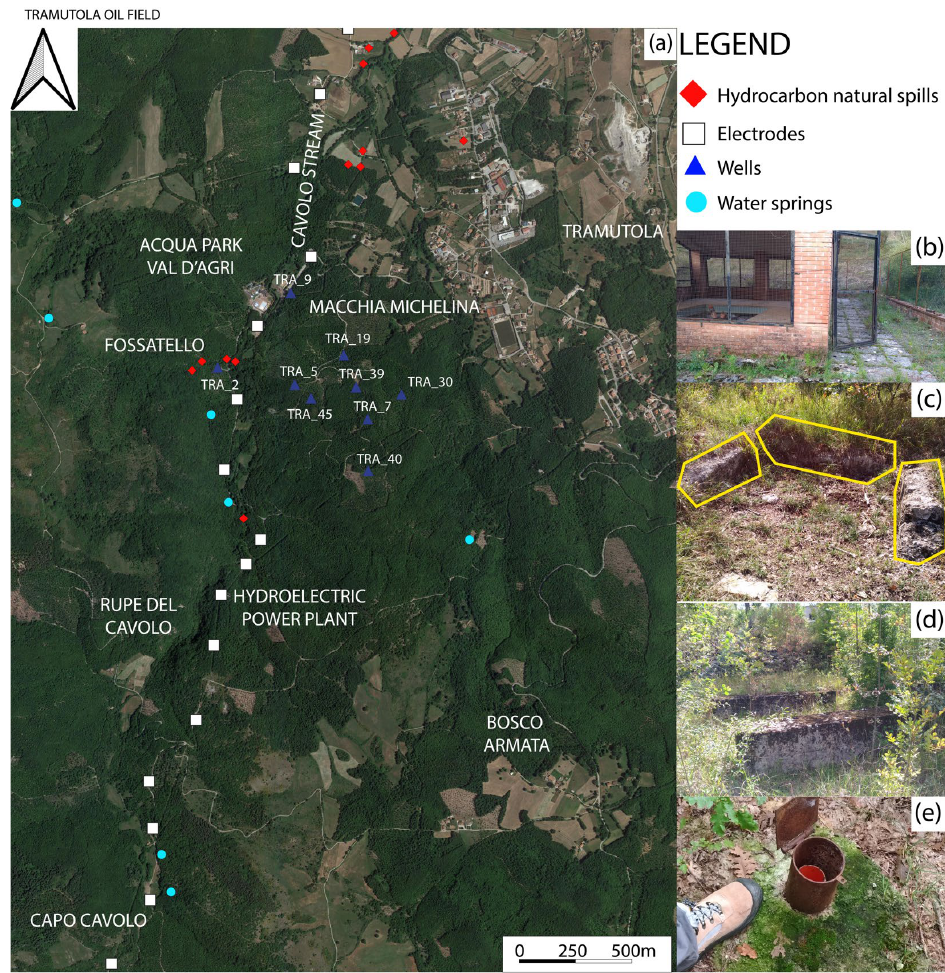
Figure 3. ( a ) Locations of natural oil spills, electrodes used for the DERT, wells of the Tramutola oil field and water springs on a Google Earth image; ( b ) the TRA_ 2 well; ( c , d ) concrete blocks (highlighted with yellow box in ( c )) of the extraction plant; and ( e ) the wellhead.